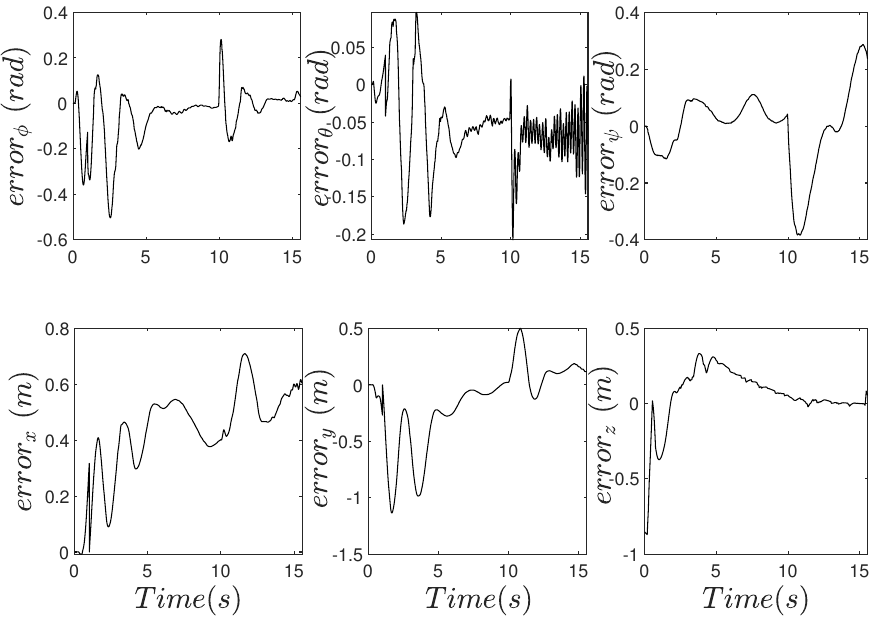
Figure 9. Error. Reference versus variable state under